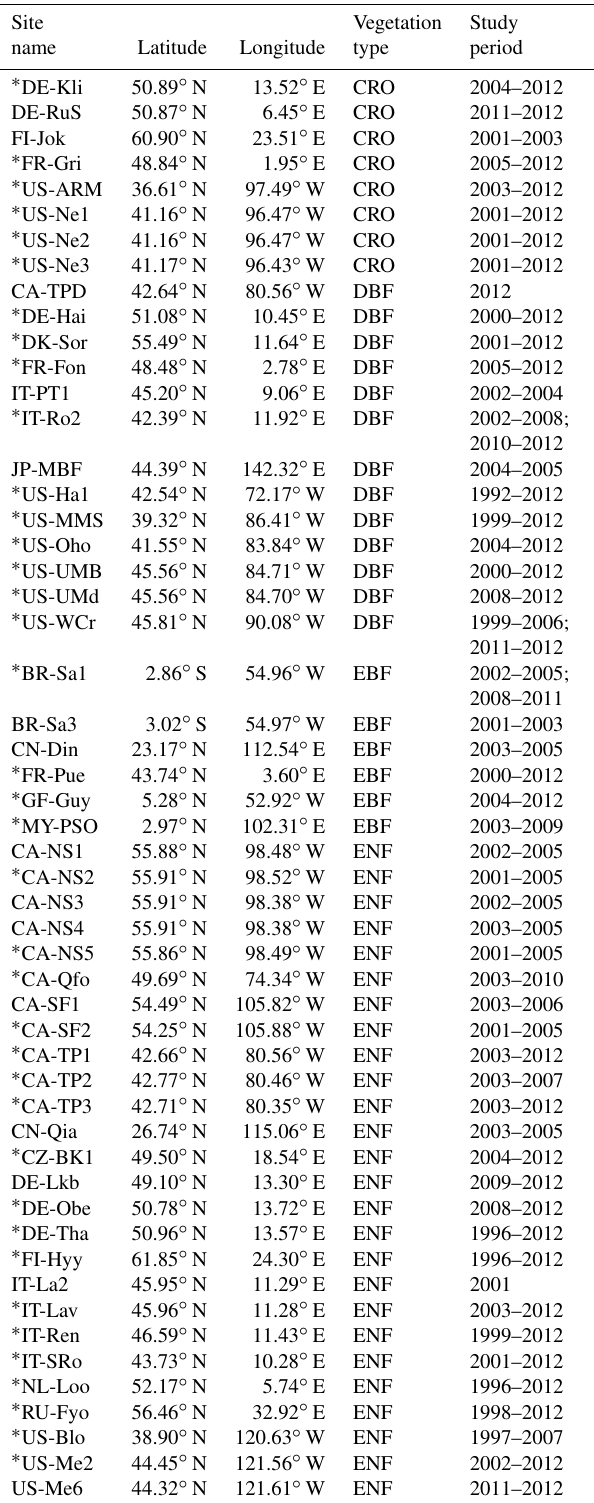
Table 1. Information on the eddy covariance (EC) sites used in this